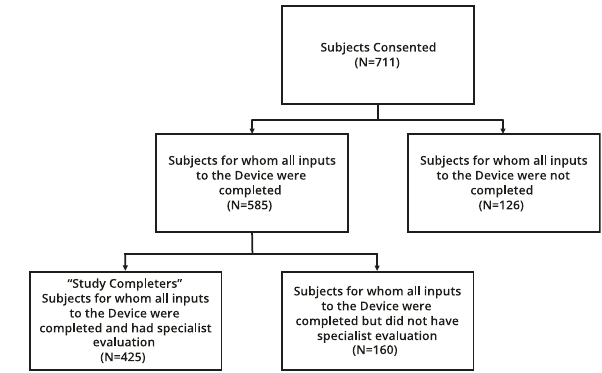
Fig. 2 Participant fl owchart. A total of 711 participants enrolled in the study between August 2019 and June 2020. Of these participants, 126 dropped out prior to completing all Device inputs. A further 160 dropped out after completing all Device inputs but prior to completing the specialist evaluation. In total, 425 participants completed all Device inputs and the specialist evalua- tion and were counted as study